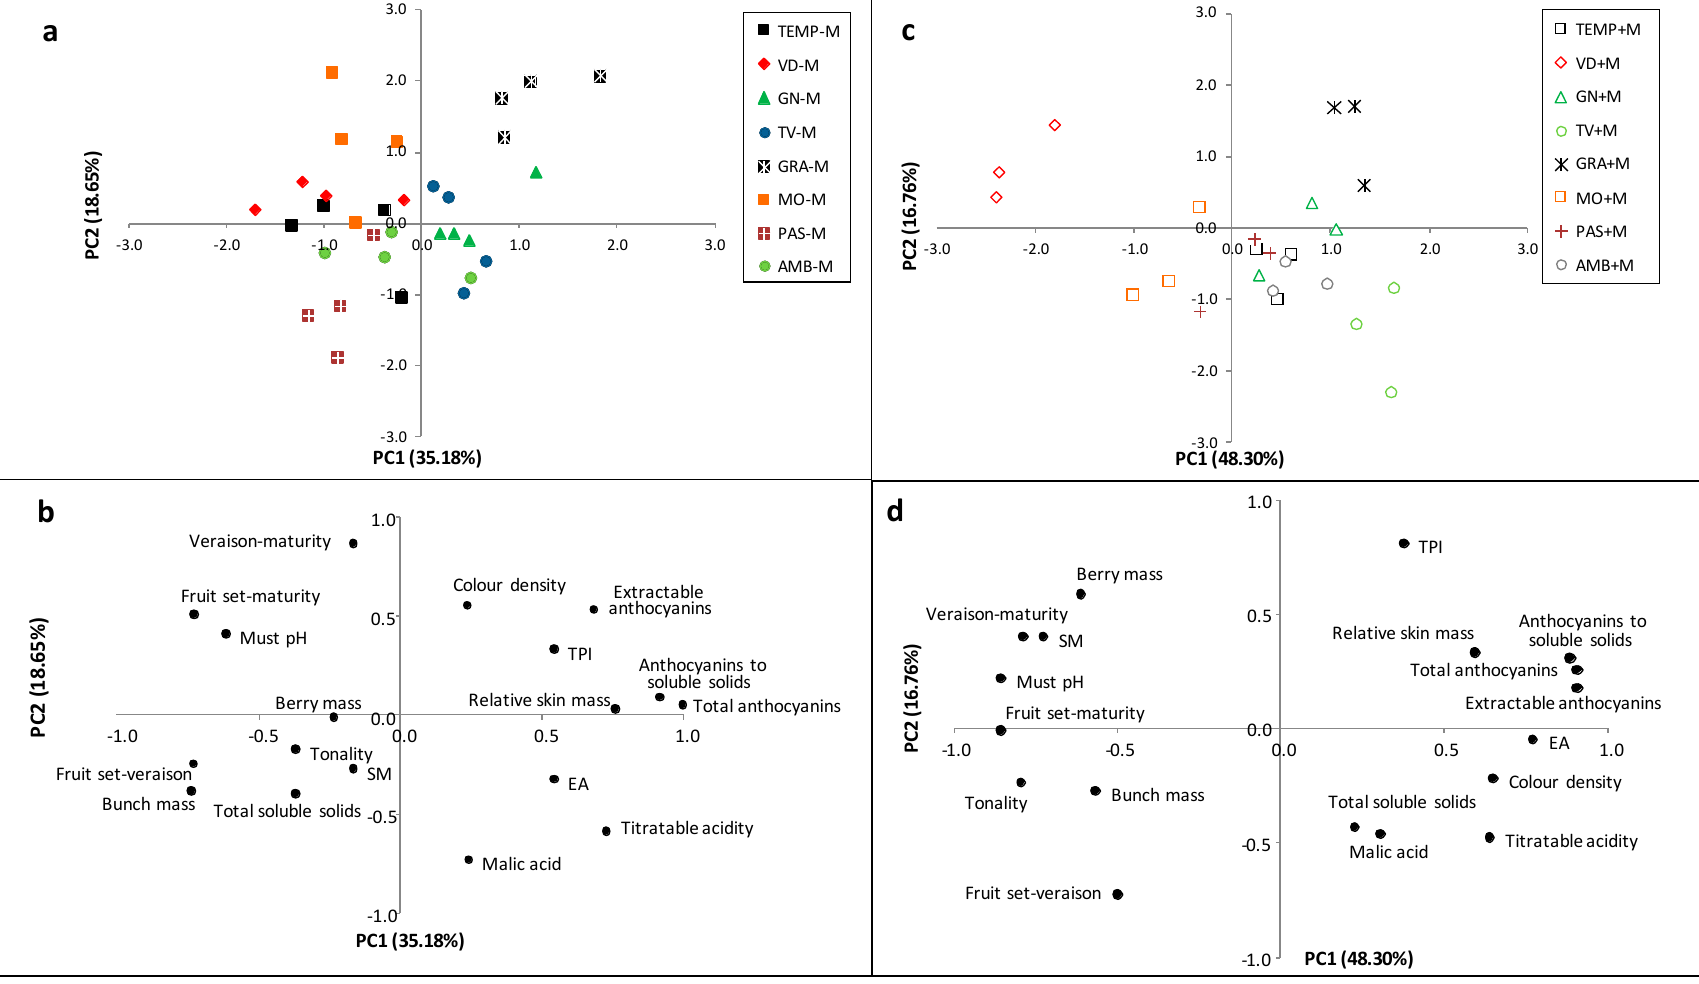
Figure 3. Principal component analysis score ( a , c ) and loading plot ( b , d ) obtained from the statistical analysis of plant and berry characteristics data of 28 studied samples from fruit-bearing cuttings of some ancient grapevine varieties inoculated with arbuscular mycorrhizal fungi ( a , b ) or uninoculated ( c , d ).